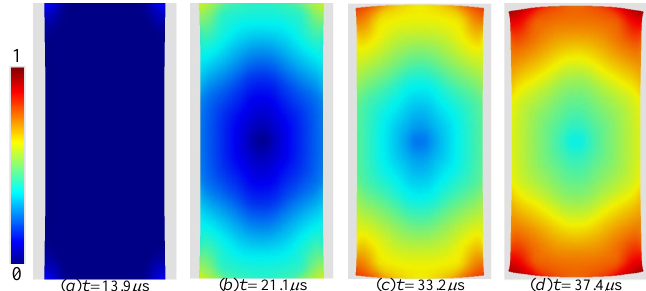
Figure 9. Damage evolution for the medium mesh and high amplitude load at times: ( a ) 13.9 µ s, ( b ) 21.1 µ s, ( c ) 33.2 µ s, and ( d ) 37.4 µ s. The results are shown on the deformed meshes with a magnification factor of 300.